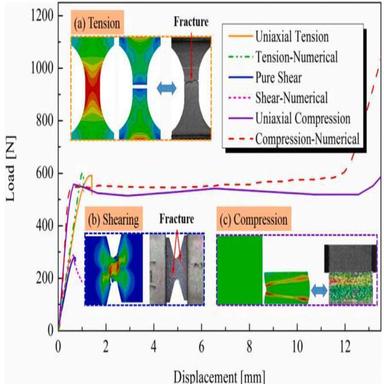
Comparison of the load-displacement responses and failure modes of PMI foams with density of 0.075 g/cm3 between numerical model and experimental tests. For all of the considered loading conditions, the FE model could well predict the load-displacement responses and failure modes of PMI foams in experiments.